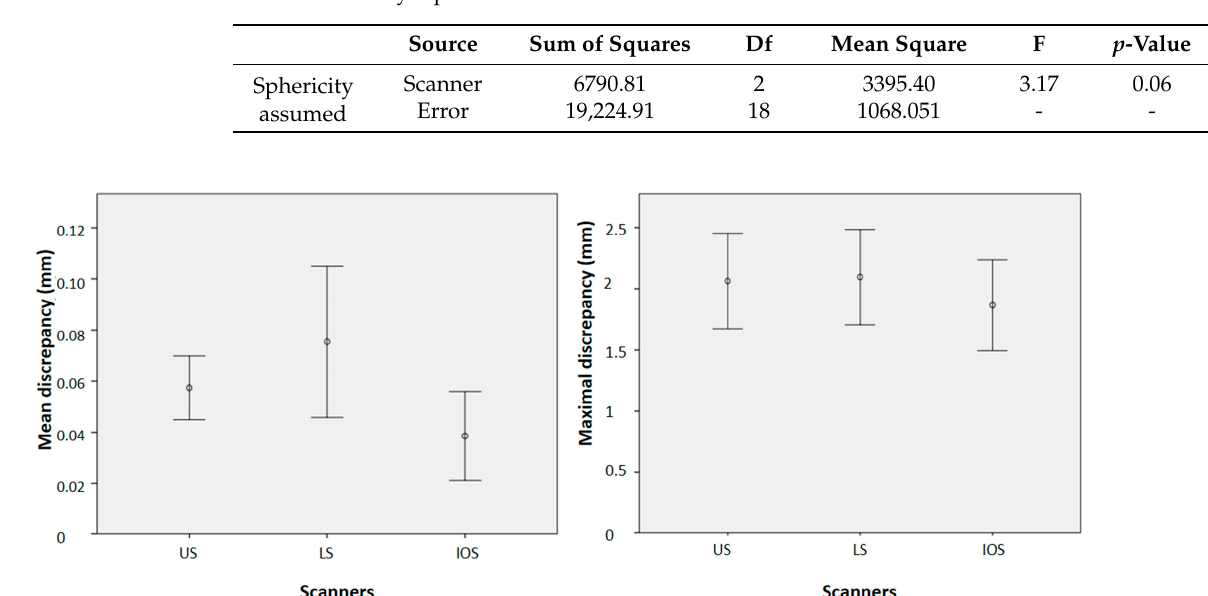
Figure 6. Mean and maximal discrepancy values obtained by ultrasound (US), laboratory scanner (LS) and intraoral scanner (IOS). No statistically significant difference was found between the scanners for the mean and maximal discrepancy values.